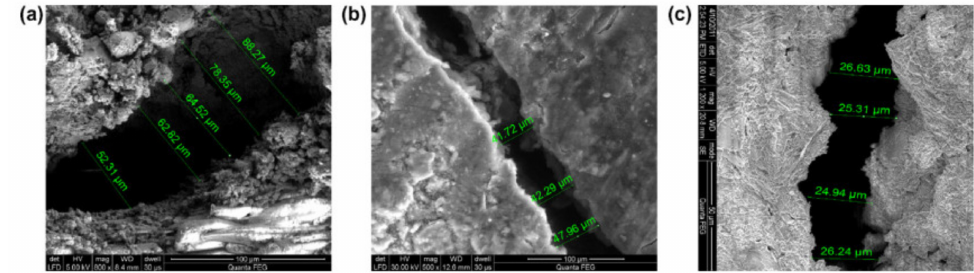
Figure 7. Crack width between cement paste and coconut shell aggregate ( a ) 3-day, ( b ) 7-day, and ( c ) 8-day [53], with copyright permission from